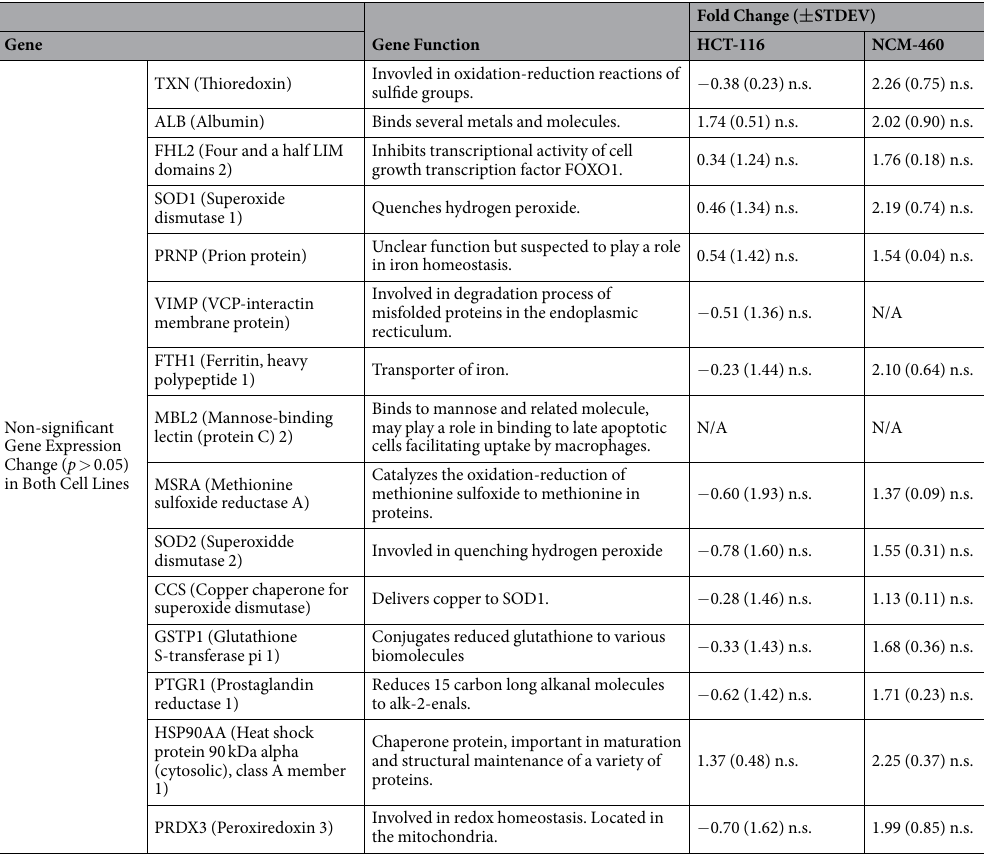
Table 7. Summary of the Relative-Fold Change in Gene Expression Utilizing RT 2 PCR. Statistical analysis was performed using One-Way ANOVA to relative-fold change of the control (1). * p < 0.05 vs control; ** p < 0.01 vs control; *** p < 0.001 vs control; **** p < 0.0001 vs control. n.s. = not significant, p > 0.05 vs control. N/A = not applicable due to no amplification detected. Gene function was obtained searching the UniProt or NCBI Gene